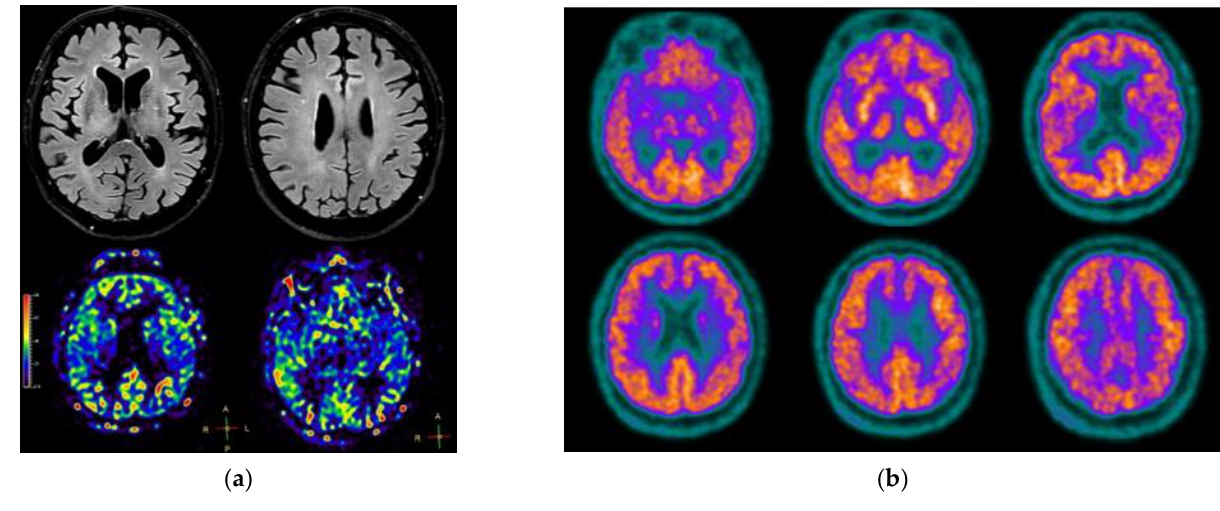
Figure 2. Imaging findings at last follow up: ( a ) Brain MRI — upper panels showing axial FLAIR slices, lower panel showing normal brain perfusion on axial arterial spin labeling slices; ( b ) FDG-PET.